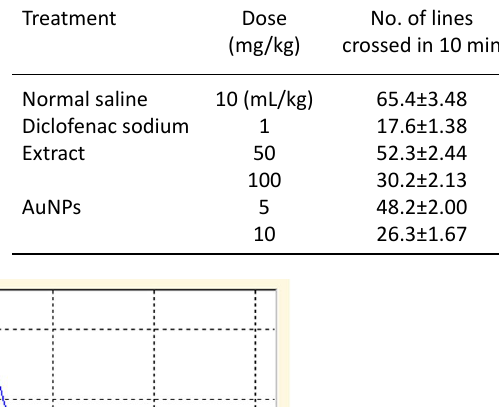
Table 4. Sedative activity of Trachyspermum ammi extract and AuNPs Treatment